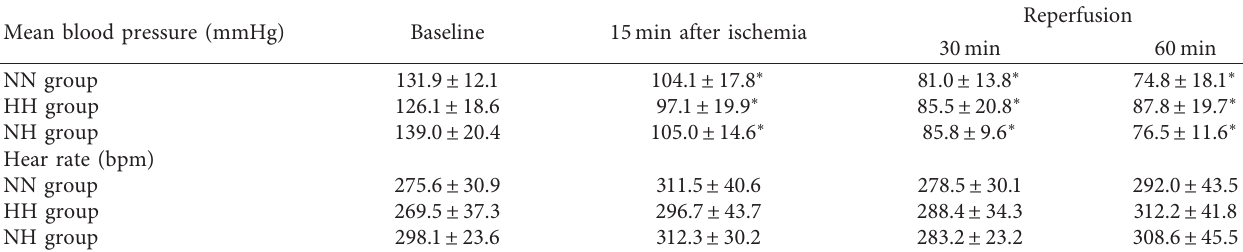
Table 1: Changes in mean blood pressure and heart rates.